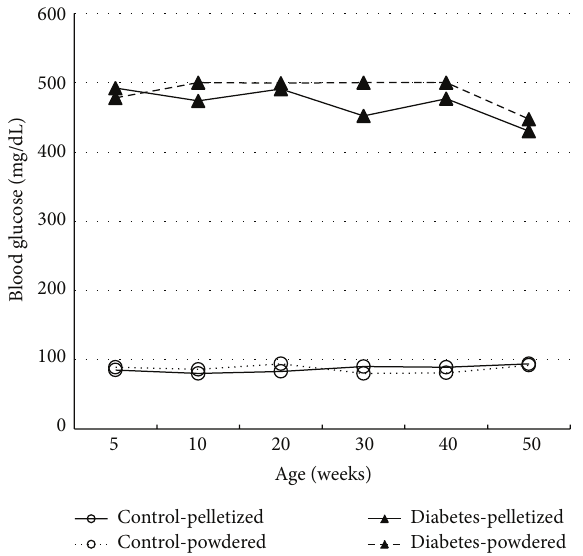
Figure 2: The mean blood glucose levels of each group. Severe hyperglycemia ( > 400mg/dL) continued from the day after alloxan dosing to the time of the scheduled necropsy in all of the alloxan- treated F344 rats. Control F344 rats showed normal glycemia ( <